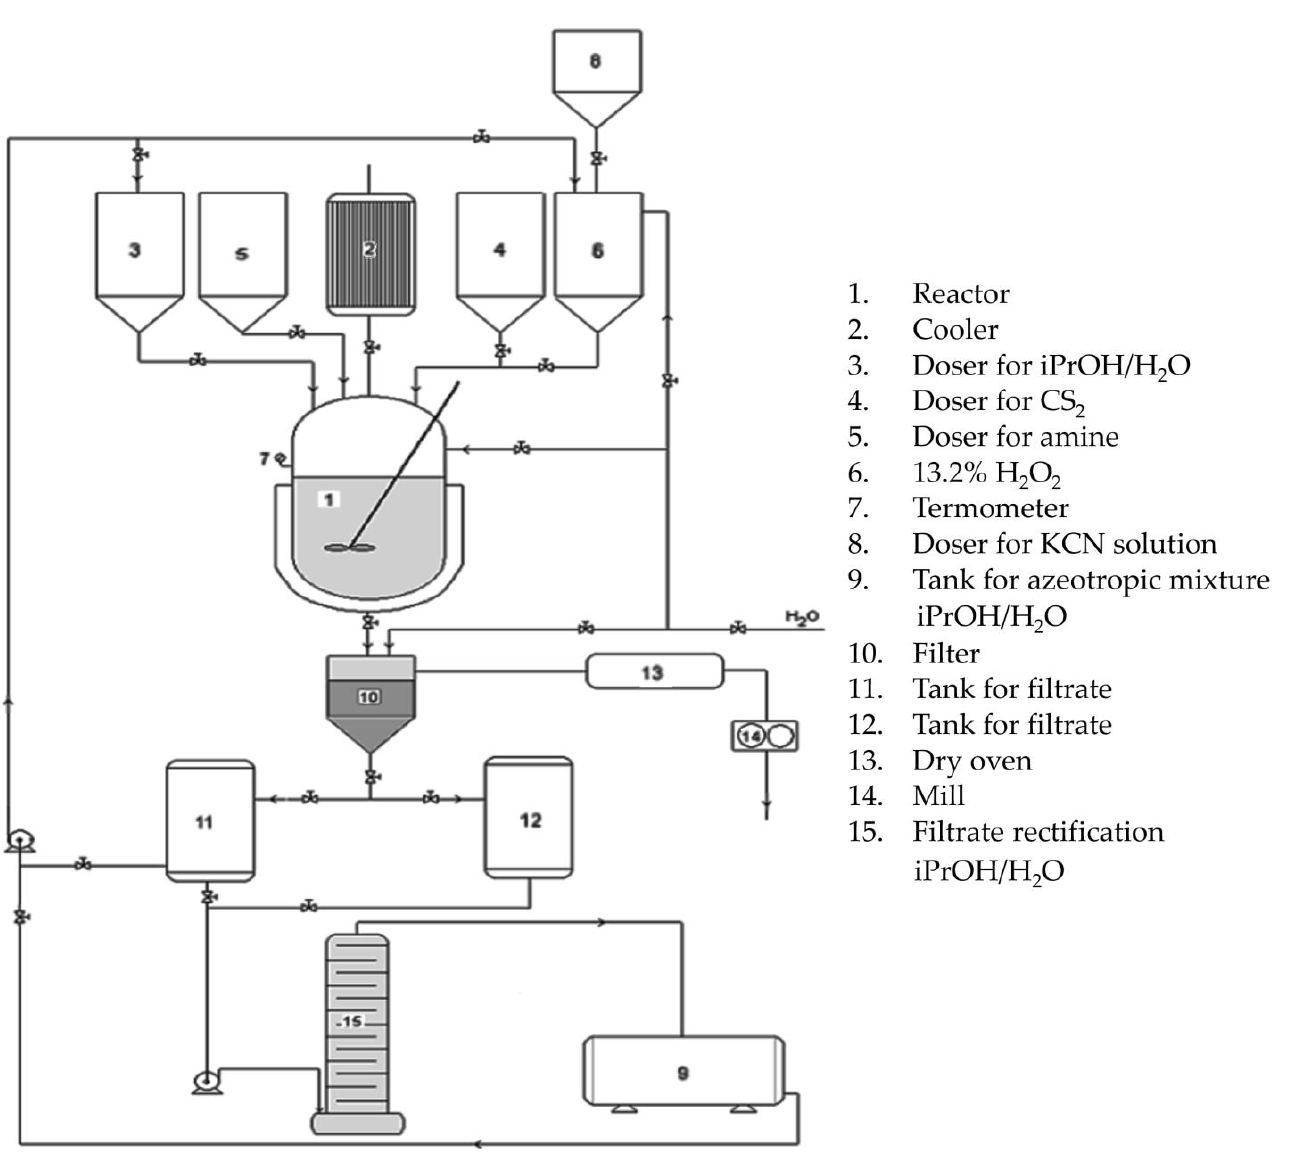
Figure 1. The technological scheme for TMTS industrial production. Safety measures were achieved by installing three scrubbers: one with 100 dm 3 of re- circulating 10% lead (II) acetate for H 2 S removal; the second with 100 dm 3 of recirculating 2 mol/dm 3 KOH water solution mainly for HCN and CS 2 removal; and the third with 2 mol/dm 3 KOH ethanol solution for CS 2 removal in the form of potassium ethyl xanthate. Results of the characterization of TMTD and TMTS (industrial level) are given in Table 7. Table 7. The physico-mechanical characteristics of the accelerators TMTS and TMTD. Accelerator